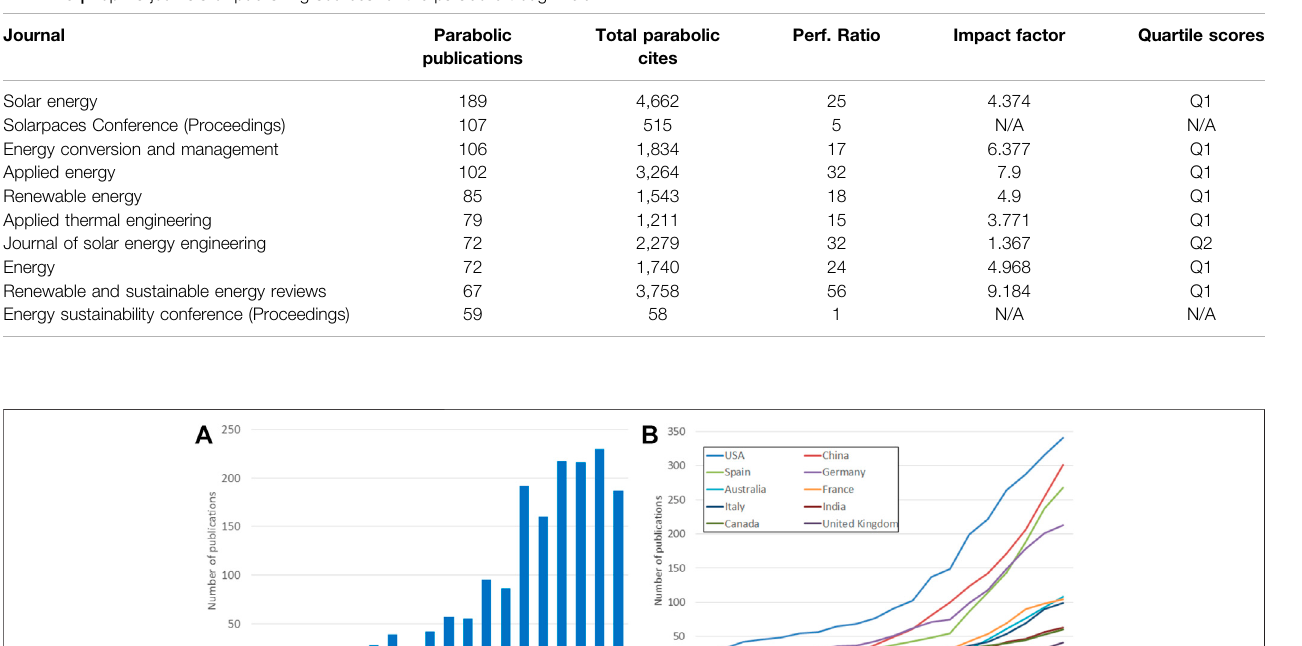
TABLE 9 | Top 10 journals or publishing sources for the parabolic trough fi eld.